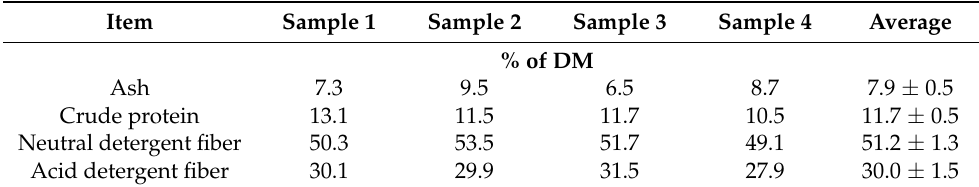
Table 3. Chemical compositions of the pastures during the